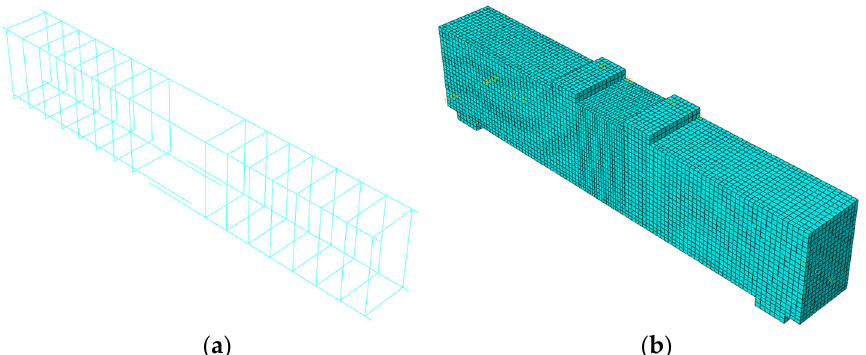
Figure 12. Finite element model meshing: ( a ) steel bar cage; ( b ) UHPC beam and steel plate.